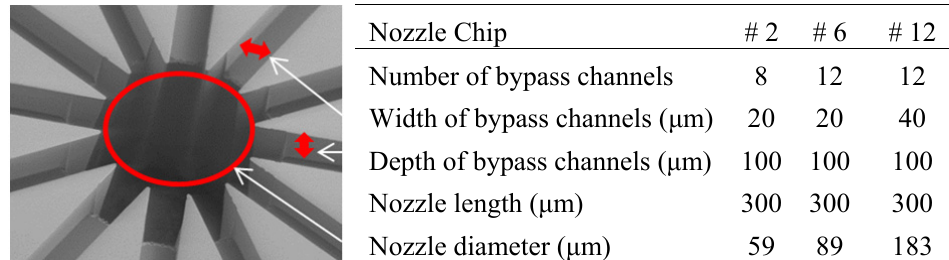
Table 1. Dimensions of the nozzle